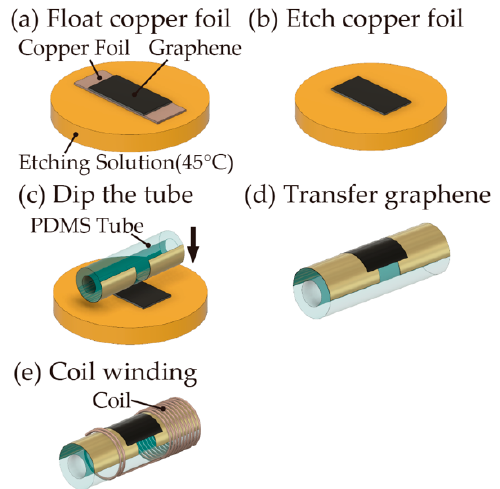
Figure 4. The graphene transfer and coil winding processes.